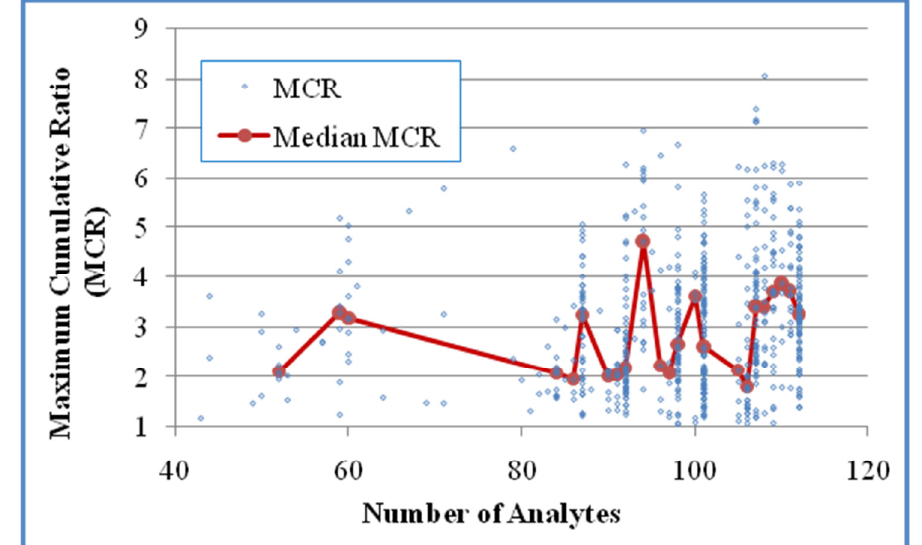
Figure 6. The relationship between MCR and the number of analytes in the samples for Case 2 (618 mixtures). A positive correlation was shown based either on all mixtures (Kendall’s τ = 0.1501 and p < 0.0001) or on median MCR values of grouped mixtures for groups with at least five values (τ = 0.3202 and p <